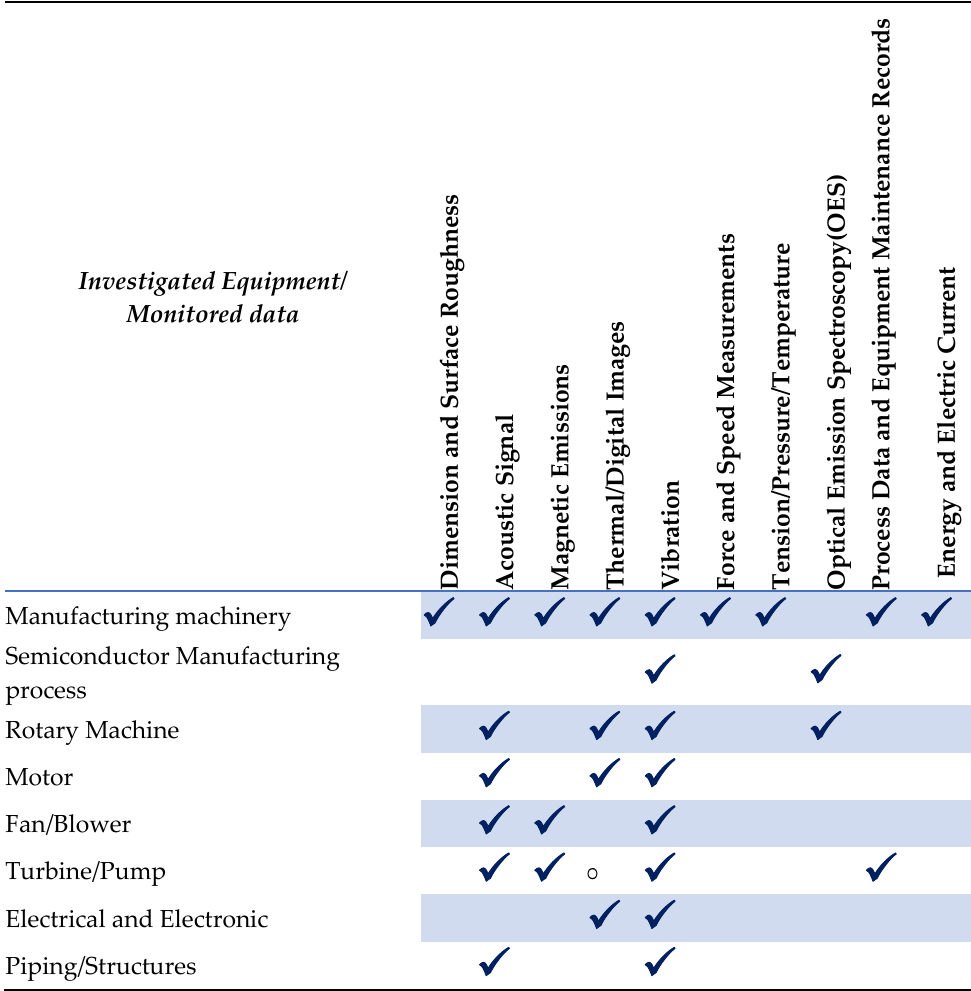
Table 5. Real-world system components investigated and their measurable sensor data [11].